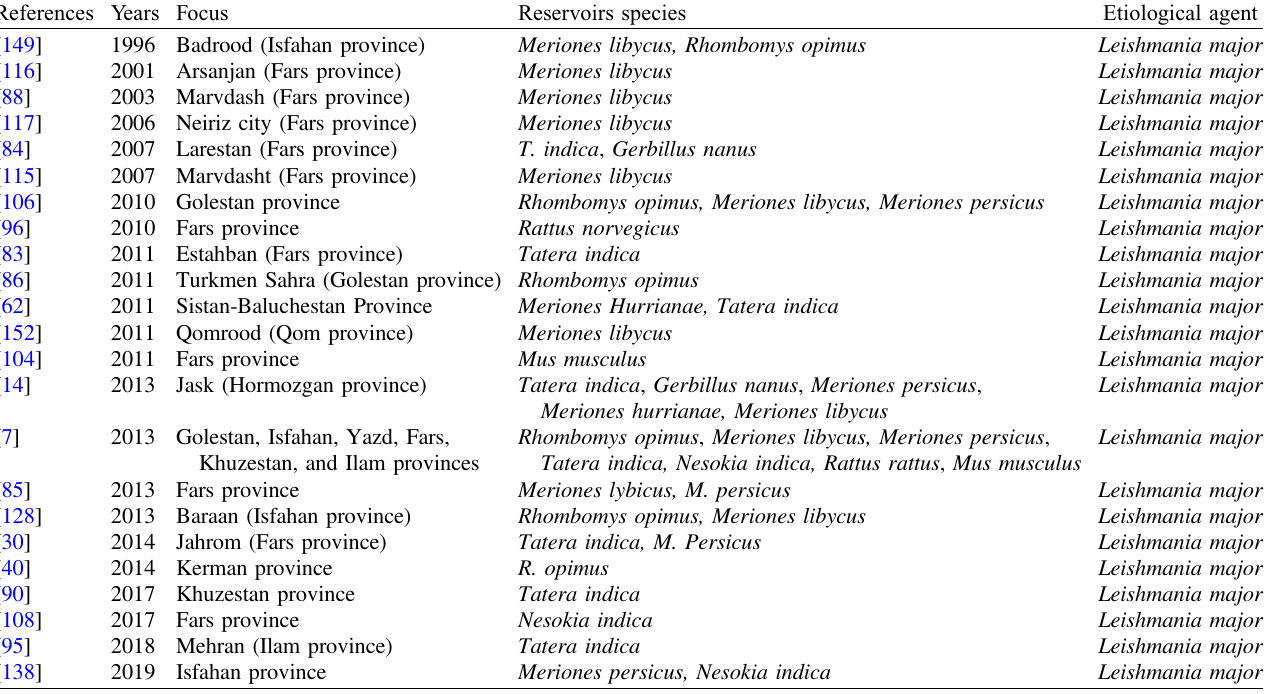
Table 1. Reservoirs of cutaneous leishmaniasis in